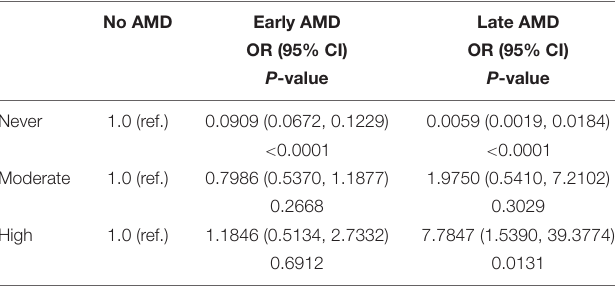
TABLE 4 | Multinomial logistic regression model of the relationship between any AMD and 100% fruit juice consumption. Exposure